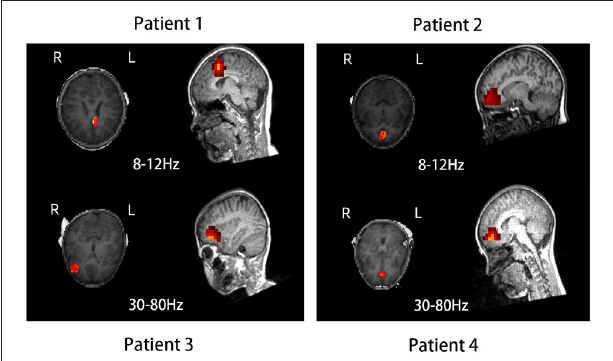
FIGURE 3 | Source location in the dorsal medial frontal cortex (patient 1), medial prefrontal cortex (patients 2 and 4), and lateral frontal cortex (patient 3) in four typical nonresponders at 8–12 and